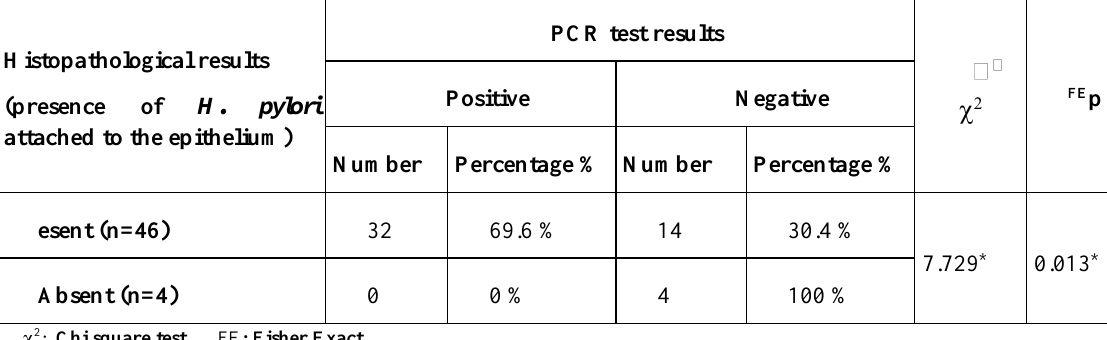
Table 2. Association between histopathological findings of H. pylori and PCR test